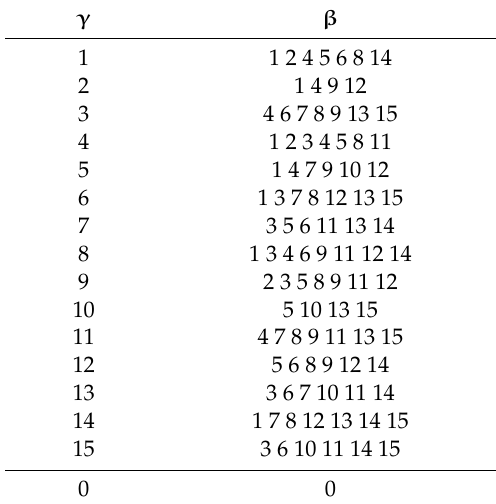
Table 3. Di ff erence distribution of Midori inverse